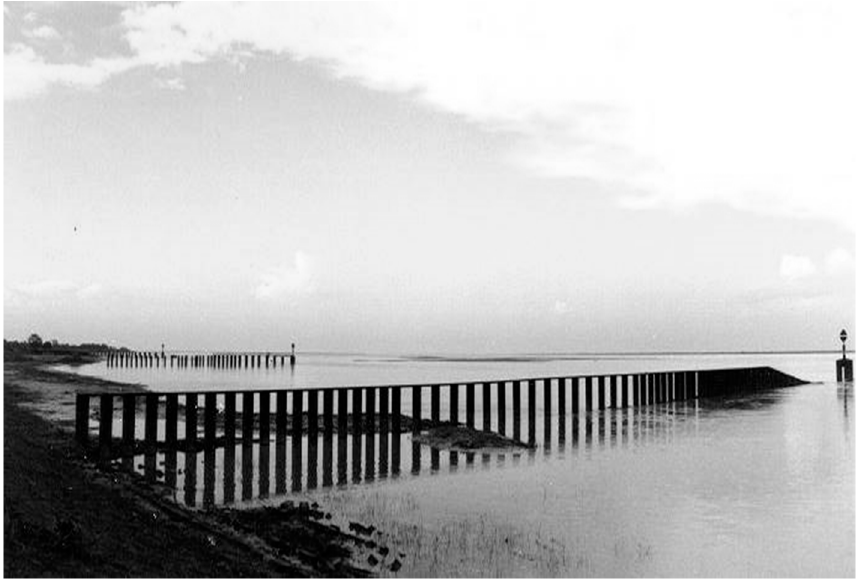
Figure 5. The approximately 200 m long central spur at Kamarjani during the 1997 flood (the embankment slope is on the left side of the photo) (photo: author).